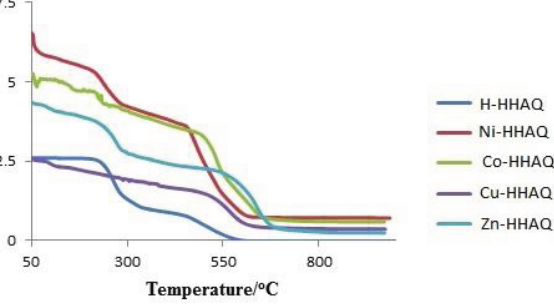
Figure 3: Thermogravimetric plots of H-HHAQ and its metal complexes. Figure 4: Differential thermogravimetric curves for H-HHAQ and its metal complexes.